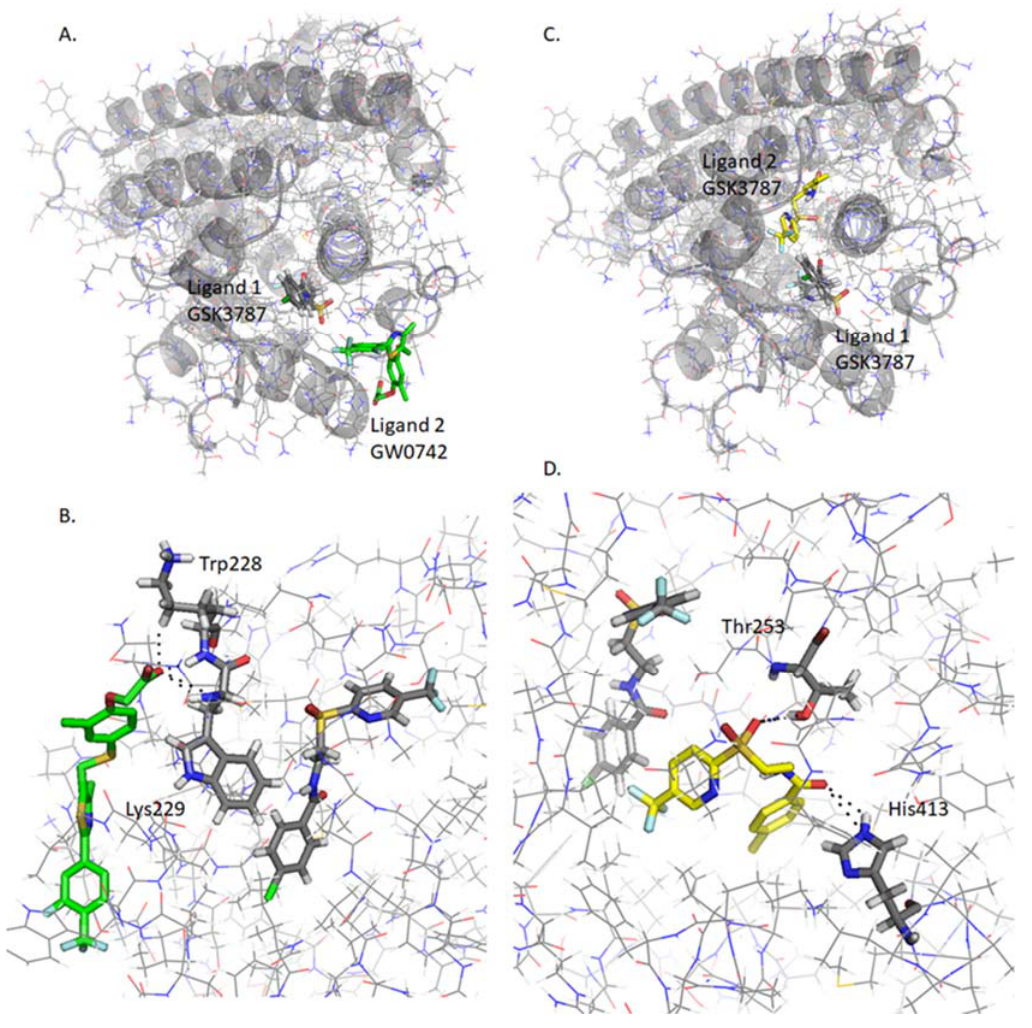
Figure 8. Analysis of GW0742 and GSK3787 docked into PPAR β / δ + GSK3787. A second molecule of GW0742 ( A , B ) or GSK3787 ( C , D ) was docked into the LBD of PPAR β / δ containing one molecule of GSK3787. ( A ) Representation of how one molecule of GSK3787 first and then one molecule of GW0742 bind into the PPAR β / δ binding pocket at same time. ( B ) Detail of the amino acids interacting with the second molecule of GW0742. ( C ) Representation of how two molecules of GSK3787 bind into the PPAR β / δ binding pocket at same time. ( D ) Detail of the amino acids interacting with the second molecule of GSK3787. Colour coding of atoms: red O, blue N, mustard S, white F, grey C PPAR β / δ and GSK3787 that binds first within the binding pocket, green C of GW0742 that binds second into the binding pocket, yellow C of GSK3787 that binds second into the binding